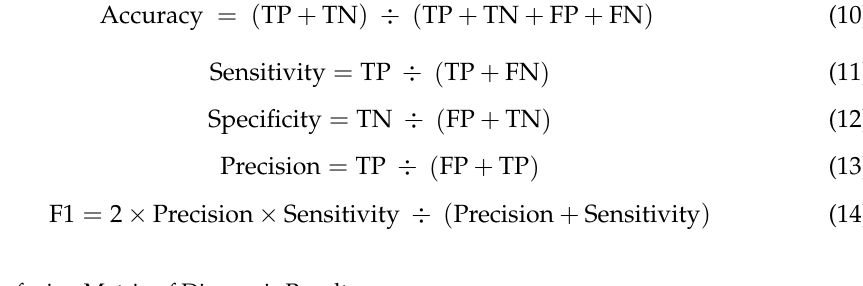
Table 4. Confusion Matrix of Diagnosis